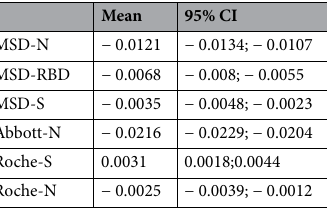
Table 3. Decay rate for each serological assay (log arbitrary units per day) estimated in a generalized linear mixed model.